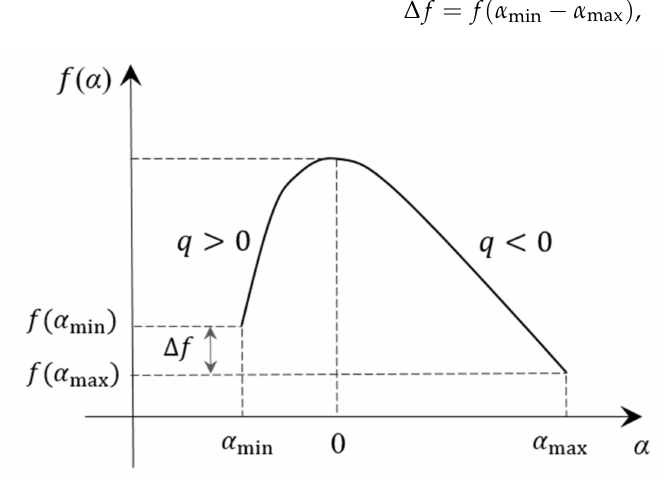
Figure 4. The typical multifractal spectrum